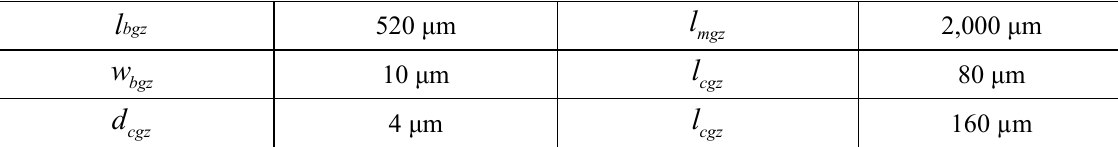
Table 7. Dimensions of Z-axis gyroscope.